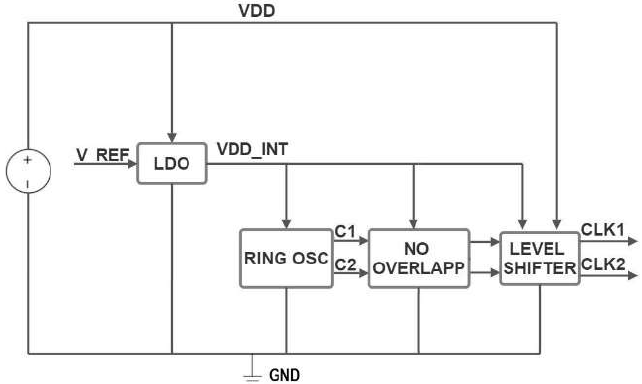
Figure 1. Proposed clock circuit block diagram with ring oscillator.